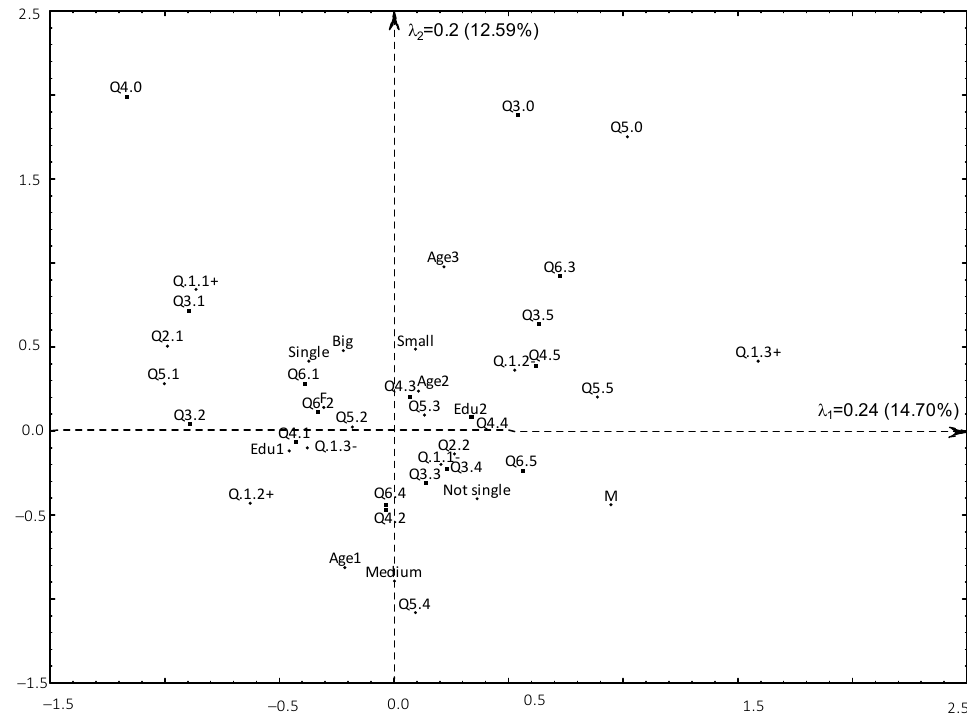
Figure 2. Touristic and physical activity of seniors. Source: Own computation using Statistica13. Among the respondents, 38 people indicated that they do not go on domestic holidays or trips, and 35 people do not go abroad for such a reason. Not participating in one of the indicated forms of tourism did not exclude participation in another. Seniors not